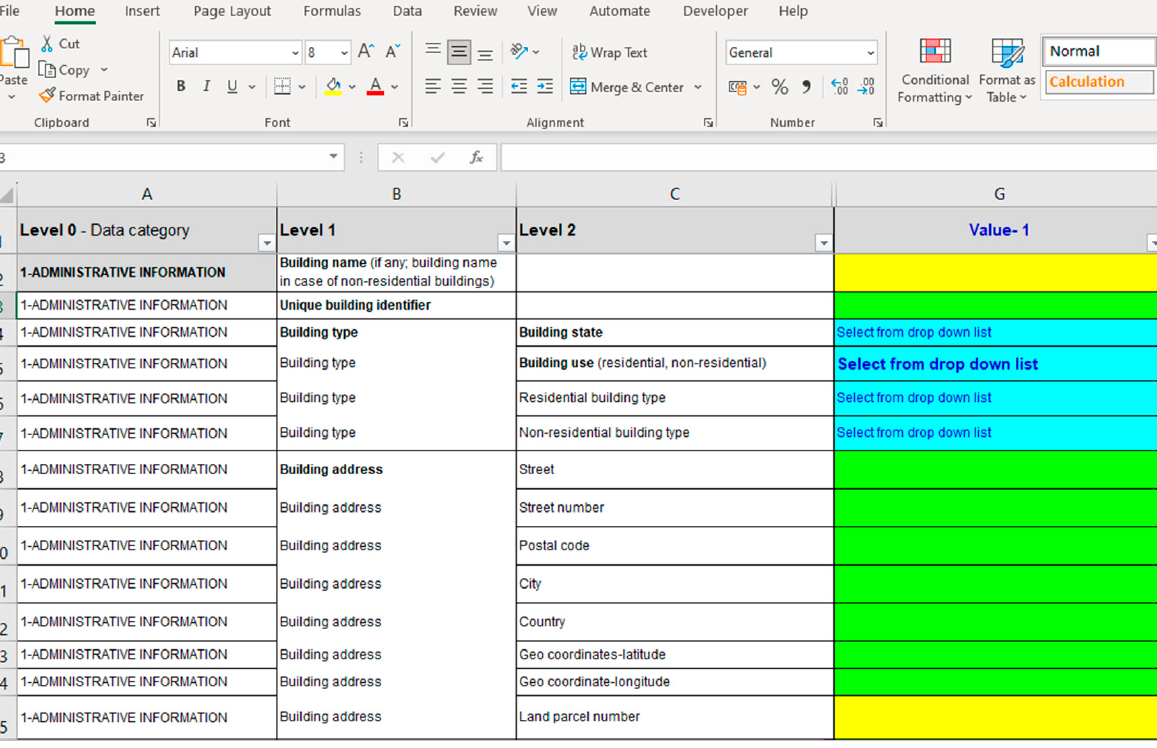
Figure 3. Screenshot of the worksheet containing the EUB SuperHub digital building logbook data structure.